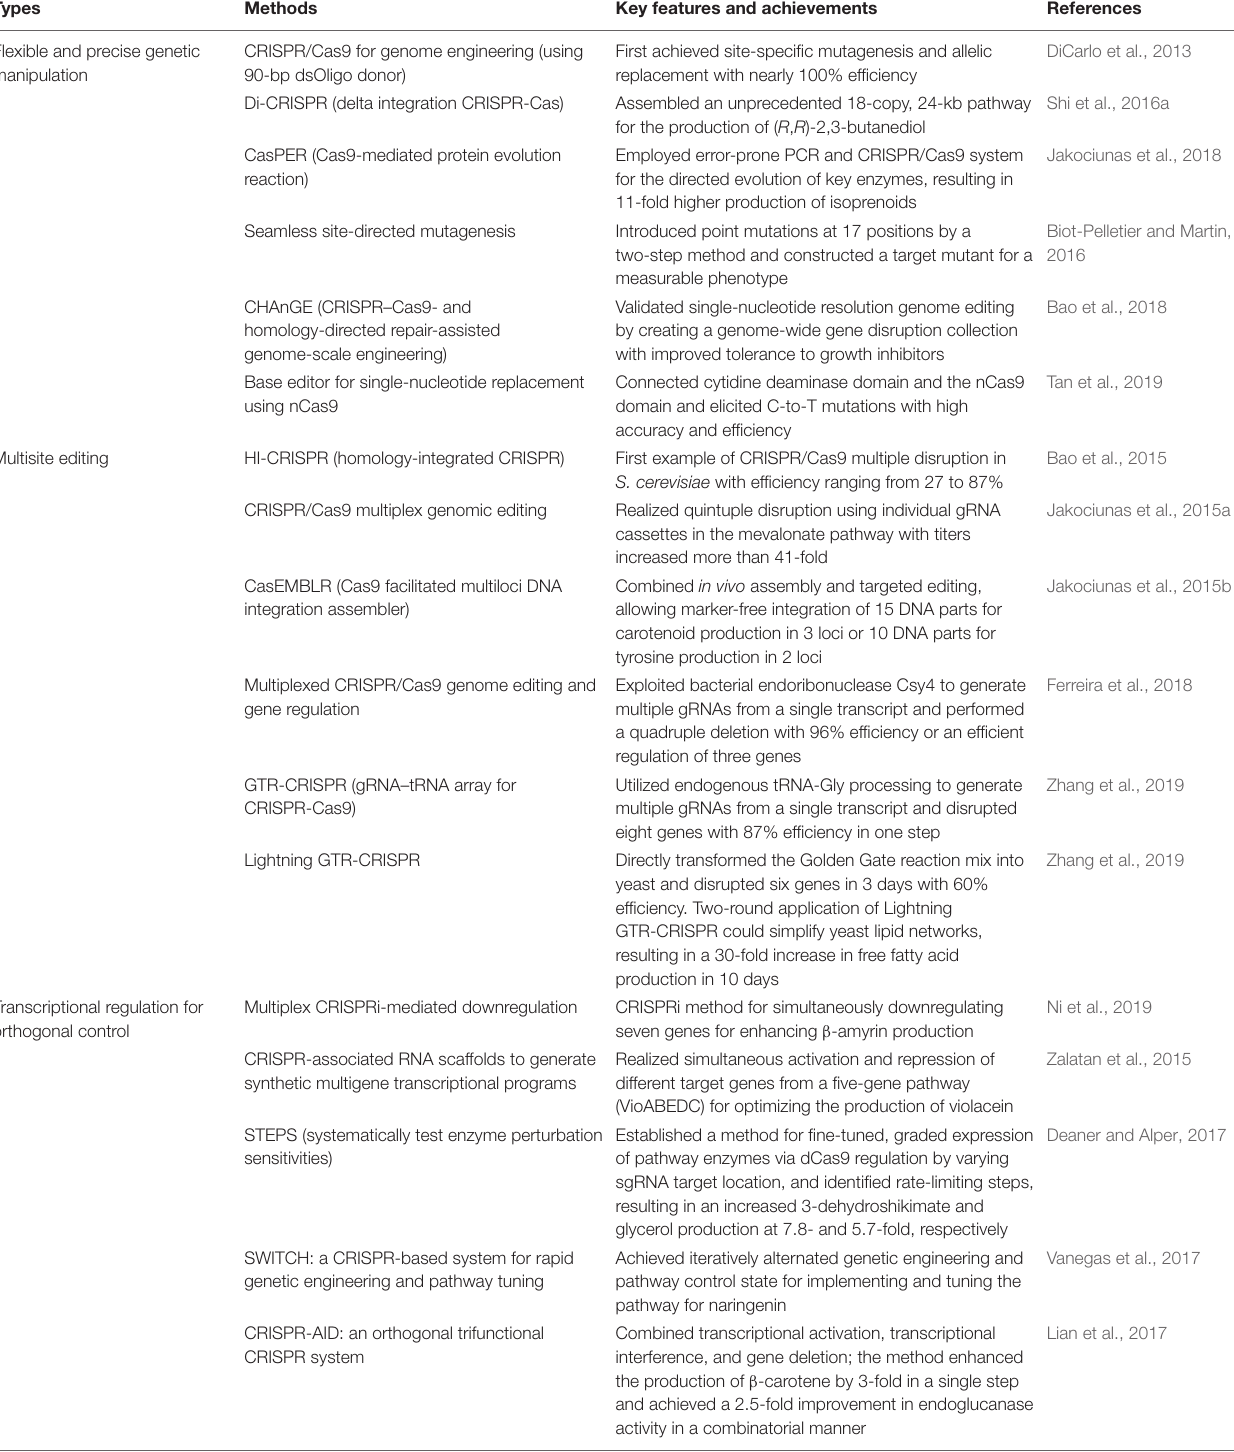
TABLE 1 | Selected clustered, regularly interspaced, short, palindromic repeat-associated (CRISPR)/CRISPR-associated protein 9 (Cas9)-associated applications in cell factory